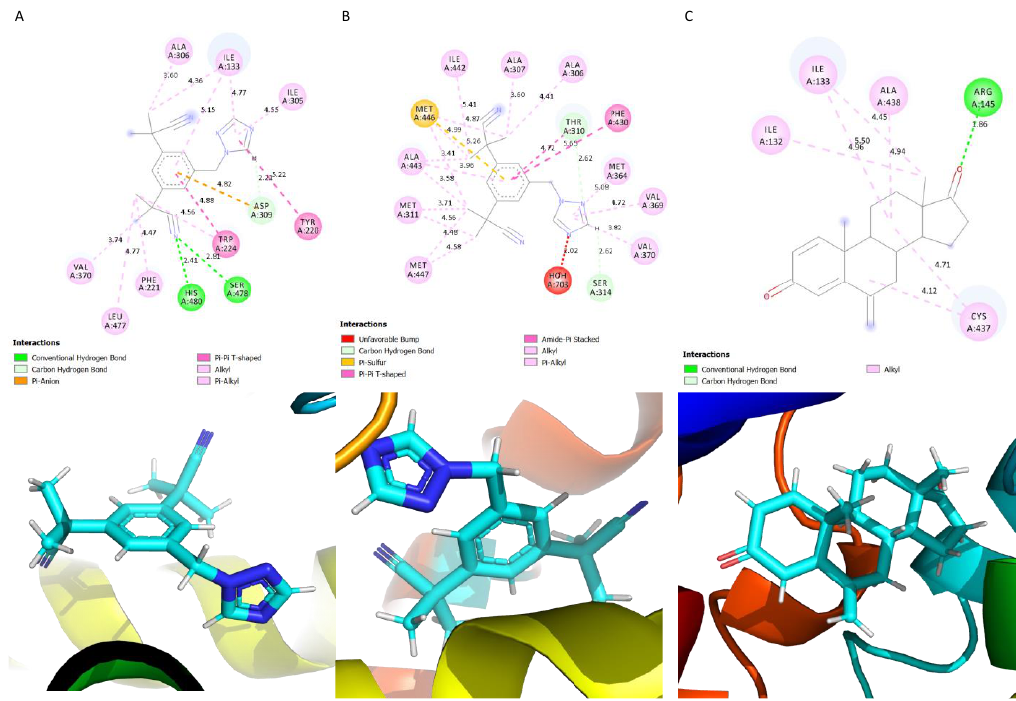
Figure 4. Schematic showing the protein – ligand interactions. ( A ) Anastrozole, ( B ) Letrozole, ( C ) Ex- emestane.